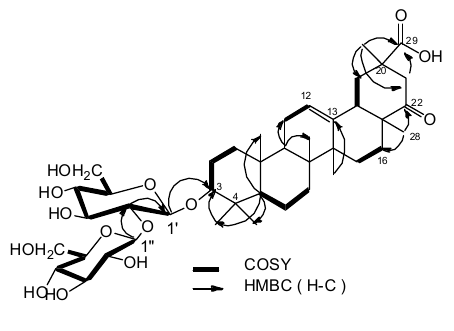
Figure 2. Key HMBC and COSY correlations of 1 .